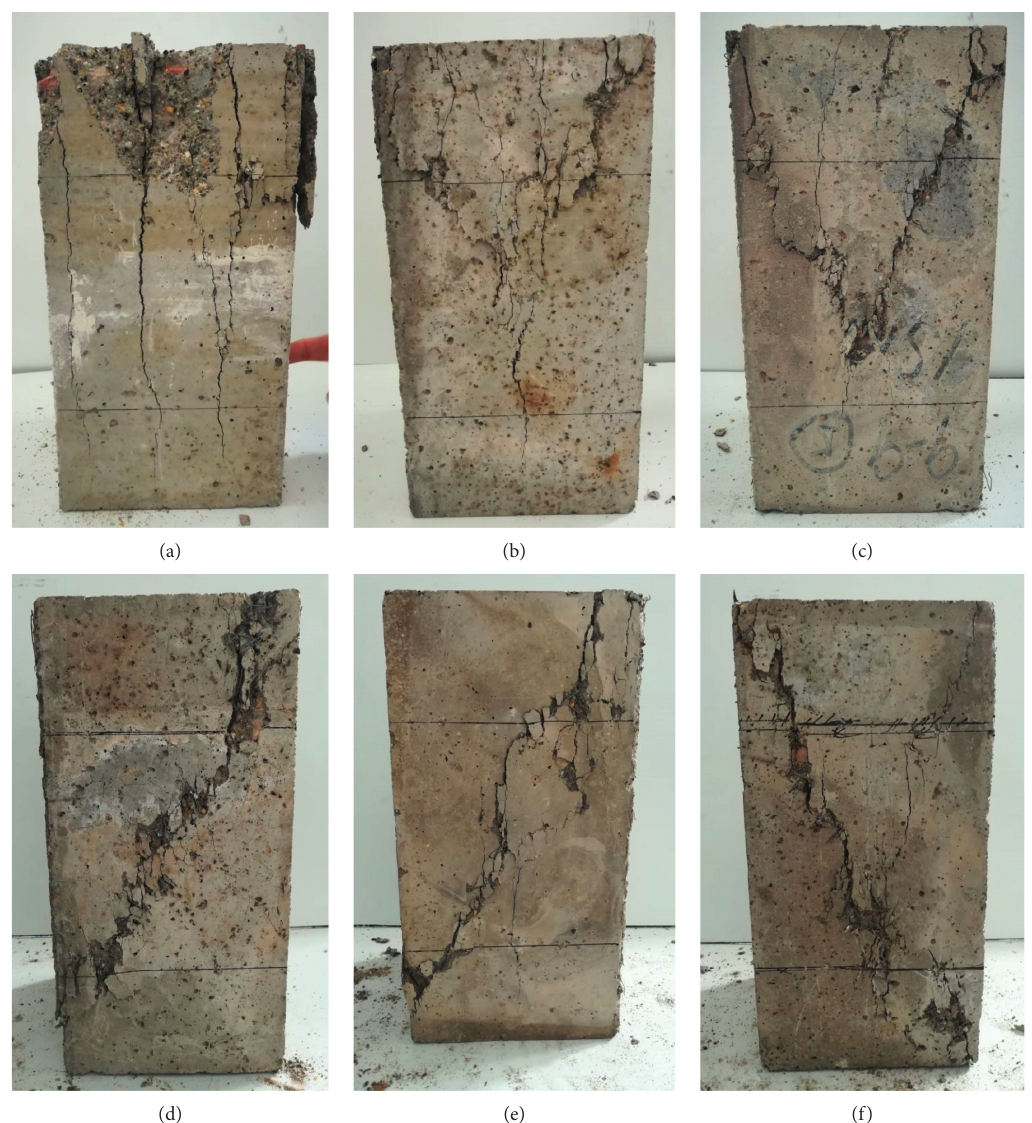
Figure 9: Failure modes of specimens. (a) CR5SF0. (b) CR5SF0.5. (c) CR5SF1.0. (d) CR5SF1.5. (e) CR5SF1NS1. (f)